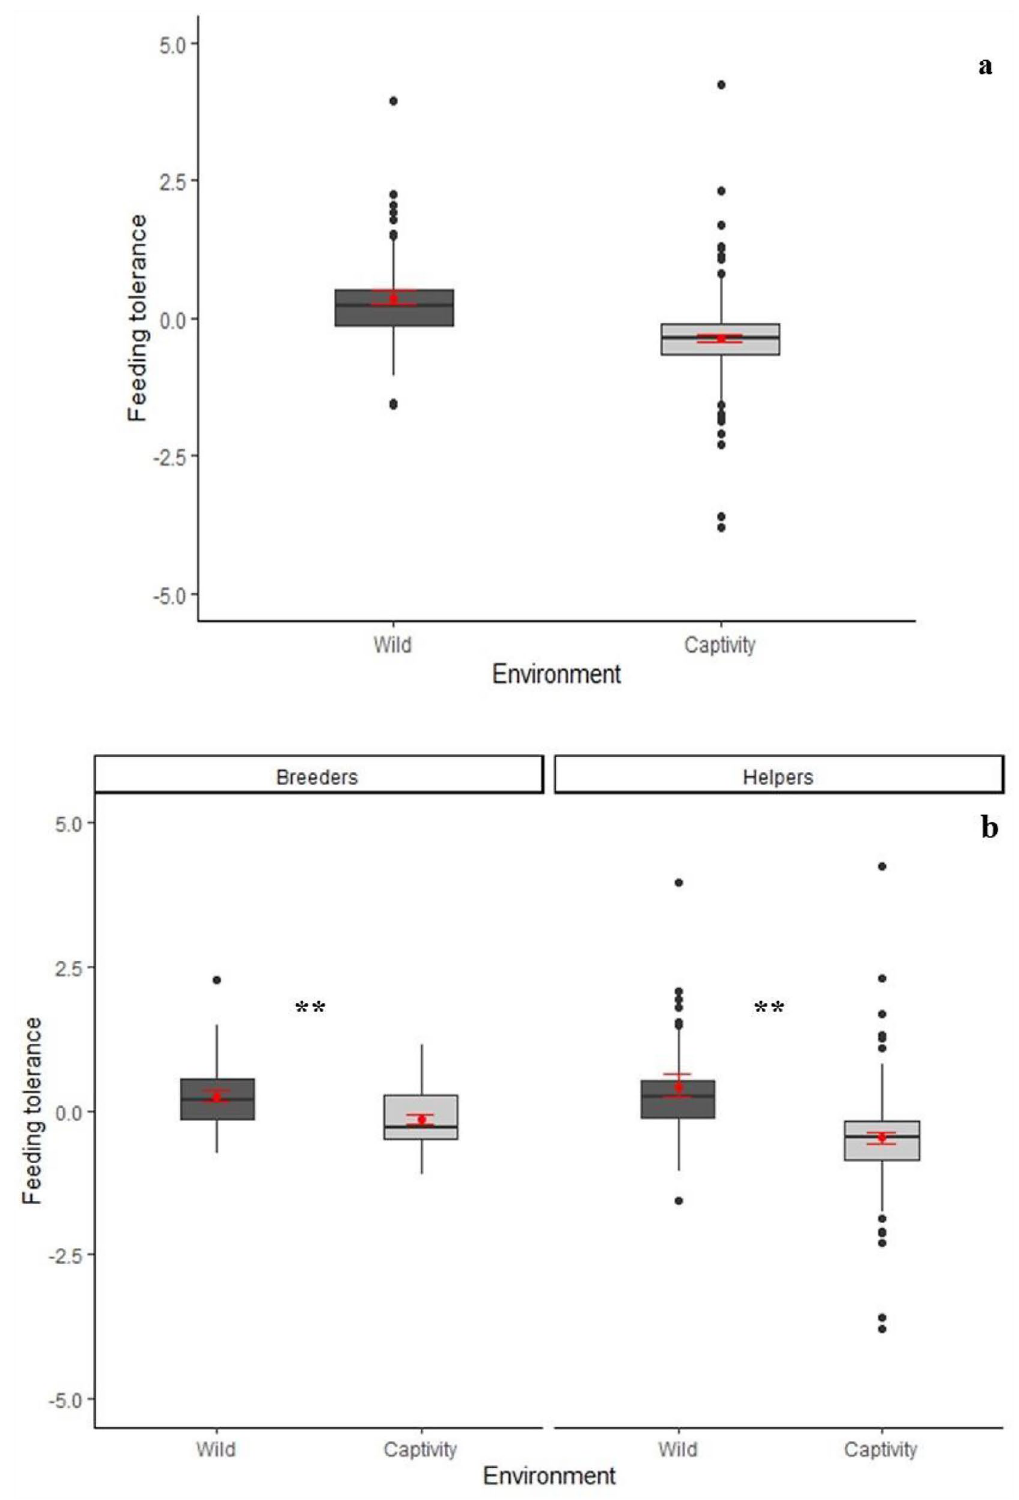
Figure 2. Feeding tolerance (PC2), split up according to ( a ) environment and ( b ) status categories. * p < 0.05, ** p < 0.01, *** p < 0.001, (Games-Howell post-hoc tests). Black lines indicate medians; upper and lower edges of boxes indicate upper and lower quartiles; whiskers indicate the ranges for the bottom and top 25% of the data values, excluding outliers; black dots indicate outliers; red dots indicate mean value and red bars indicate SEM (N = 46). Software R Studio version 1.1.463. https ://www.r-proje